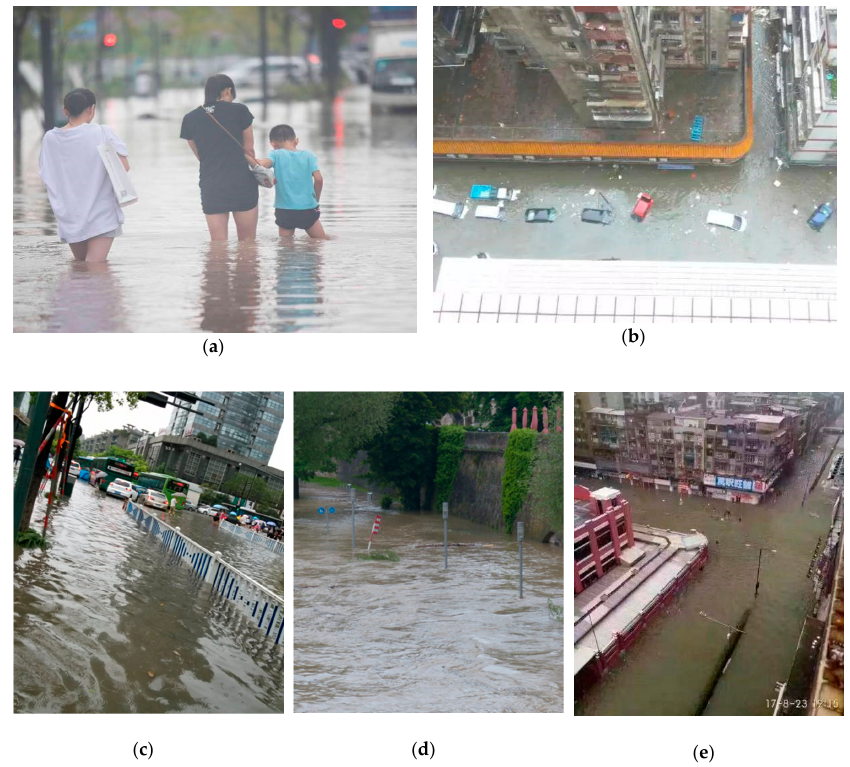
Figure 10. Photos of typical locations. ( a ) Honggang Harbor, t = 330 min (16:00); ( b ) Hengqin West Road, t = 115 min (12:25); ( c ) Baoxi Road, t = 140 min (12:50); ( d ) East Dike, t = 300 min (15:30); ( e ) Dama Road, t = 105 min (12:15).